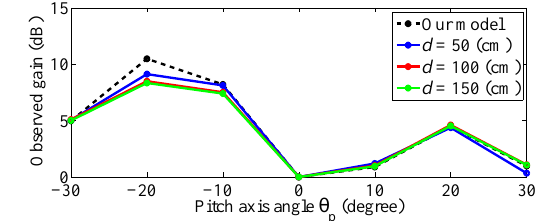
Figure 15. Observed power ratio in 500 Hz band